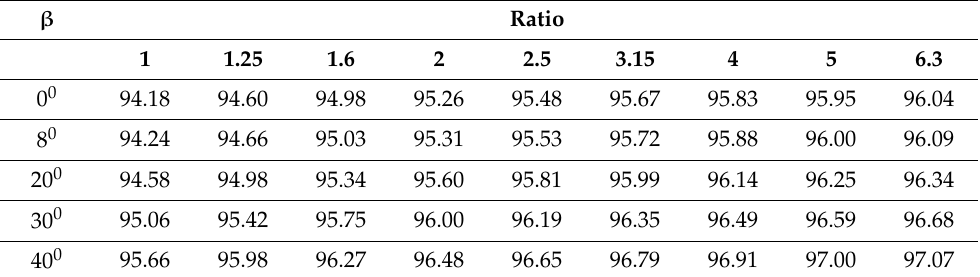
Table 5. Lookup table for gear ratio and efficiency (with lubrication).